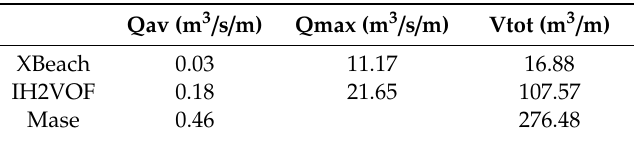
Figure 9. Overtopping flow and accumulated overtopping volume predicted using XBeach and IH2VOF for simplified representative hydro-morphologic conditions in case I.O, designed for the occurrence of overtopping. Table 4. Average and maximum overtopping flow and total overtopping volume predicted using XBeach and IH2VOF in case I.O. Average overtopping flow and total overtopping volume predicted using Mase formulas in case